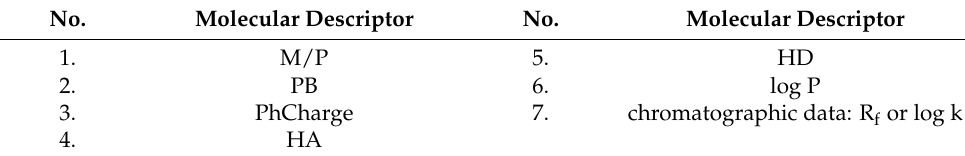
Table 7. Molecular descriptors used in random forest